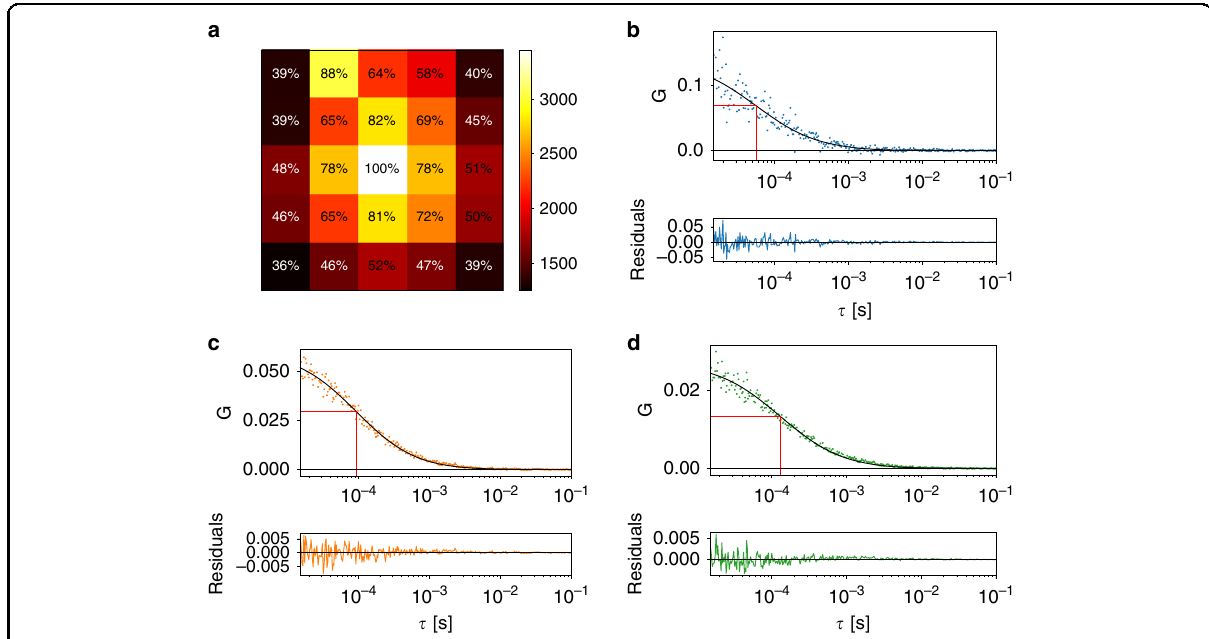
Fig. 6 FCS measurements on GFP. a Average PCR (in Hz) per pixel of the SPAD array detector for one of the FCS measurements. The percentages indicate the relative photon fl ux with respect to the central pixel. b – d ACFs and fi ts for b I 12 , c I sum3×3 , and d I sum5×5 . The fi tted diffusion times indicated in red correspond to 57 µs, 94 µs, and 132 µs,